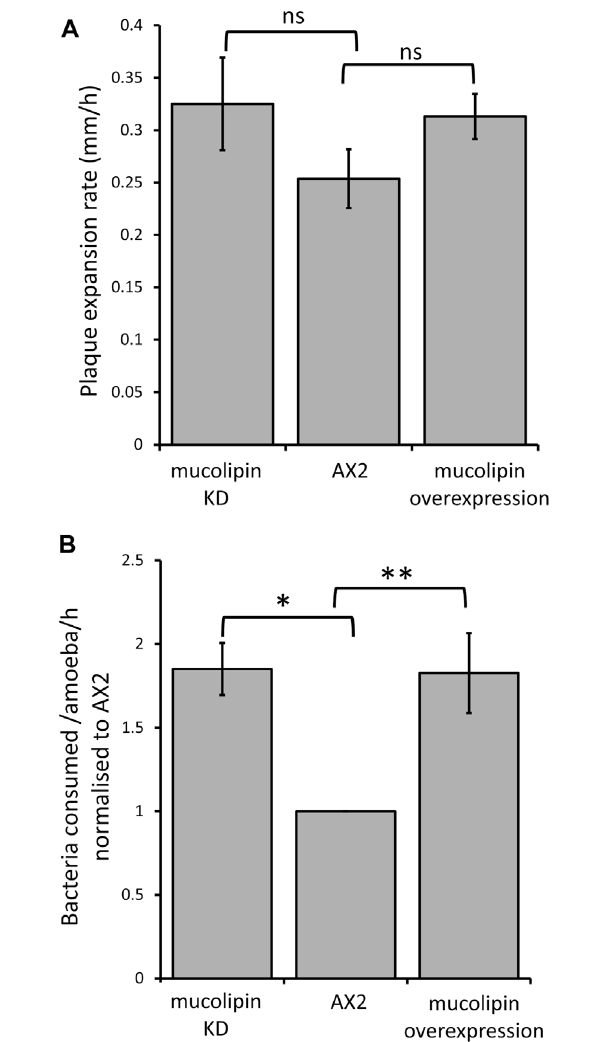
FIGURE 7 | Mucolipin expression did not affect plaque expansion rates but increased phagocytosis rates. (A) Plaque expansion rates (growth velocity) were measured from linear regressions of plaque diameters vs. time during growth at 21 ° C on an E. coli B lawn. Growth velocity was not signi fi cantly altered in mucolipin knockdown compared to AX2 ( p = 0.278) or overexpression compared to AX2 ( p = 0.133) (One-Way ANOVA, with pairwise comparisons made by the Least Squares Difference method). Analysis revealed that all there was no correlation between construct copy numberand growthvelocity ofthemucolipinoverexpressingstrainstherefore, the growth velocities for different strains in each of the two sets of transformants were pooled to calculate the means for comparison with AX2. Individual strains were each tested in 2 – 4 independent experiments and the data pooled to calculate the mean. Eight overexpression strains ( n = 33), sevenknockdownstrains( n =20)andthecontrolstrain( n =4)weretested( n = total number of experiments in each strain group). Errors are standard errors of the mean. (B) Uptake of E. coli cells expressing the fl uorescent red protein Ds-Red via phagocytosis was signi fi cantly increased in both knockdown and overexpression mucolipin transformants when compared to AX2 (* p = 3.35 × 10 – 5 , ** p = 0.002, One-Way ANOVA, with pairwise comparisons made by the Least Squares Difference method). All of the mucolipin overexpressing strains